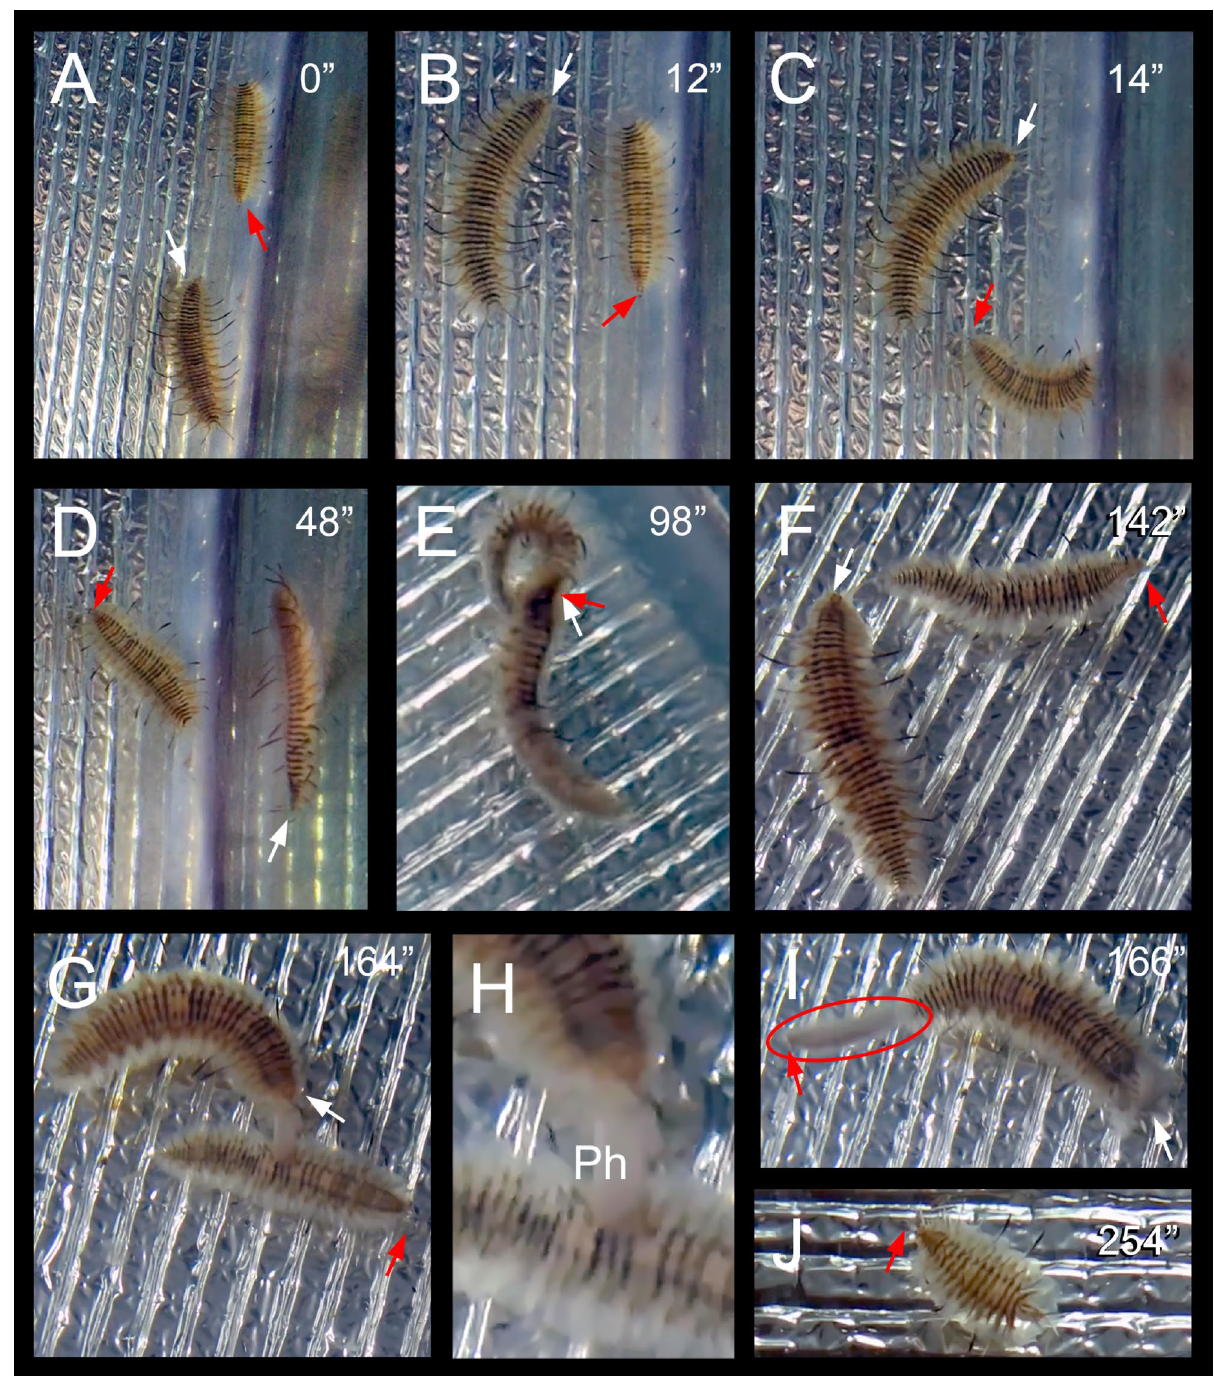
Figure 6. Sequence of two territorial attacks of a large against a small specimen of Ophthalmonoe pettiboneae outside the host tube, in which the smaller was finally torn in two; see Supplementary material S8. ( A ) Large scaleworm approaching the smaller. ( B ) Large scaleworm overpassing the smaller, the smaller moving to face the larger. ( C ) Large scaleworm after a sudden movement to find the adequate position for attack. ( E ) First attack. ( F ) Small scaleworm moving slowly, large scaleworm preparing a second attack. ( G ) Large scaleworm just everting its pharynx during the second attack. ( H ) Close view of the start of the second attack. ( I ) Anterior region of the small scaleworm (red oval) quickly moving out of the attack zone after being autotomized, posterior region still trapped by the pharynx of the large scaleworm. ( J ) Detail of the anterior fragment of the small symbiont after the attack. Ph: Pharynx. White arrows indicate the head of the large specimen; red arrows indicate the head of the small specimen. Time course indicated in